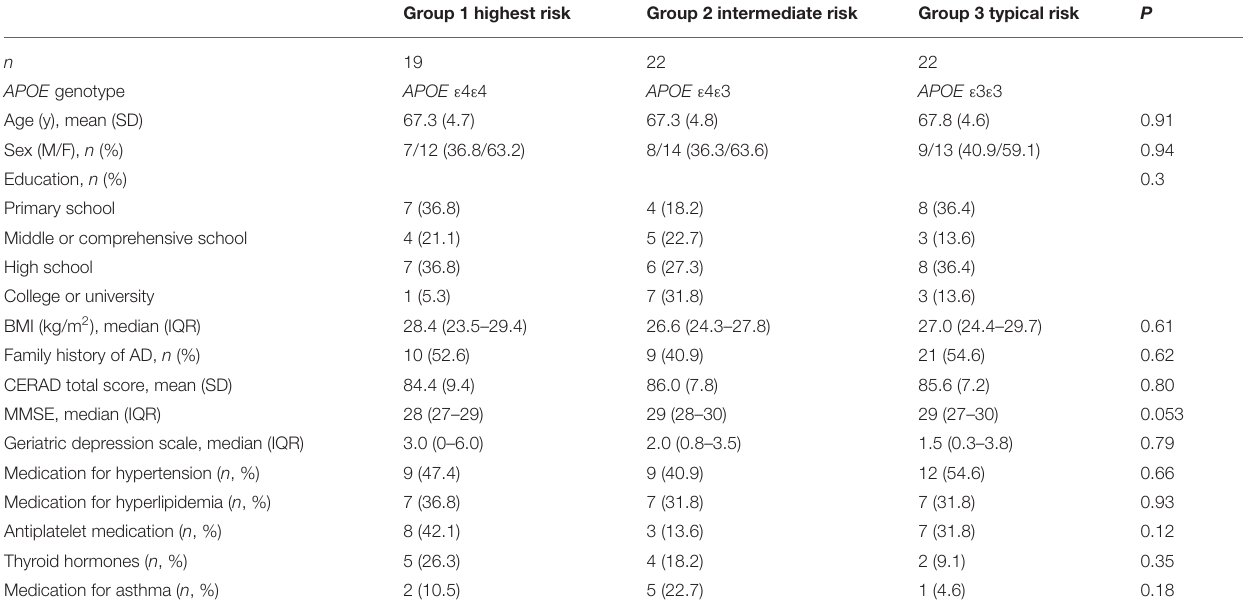
Group 1 highest